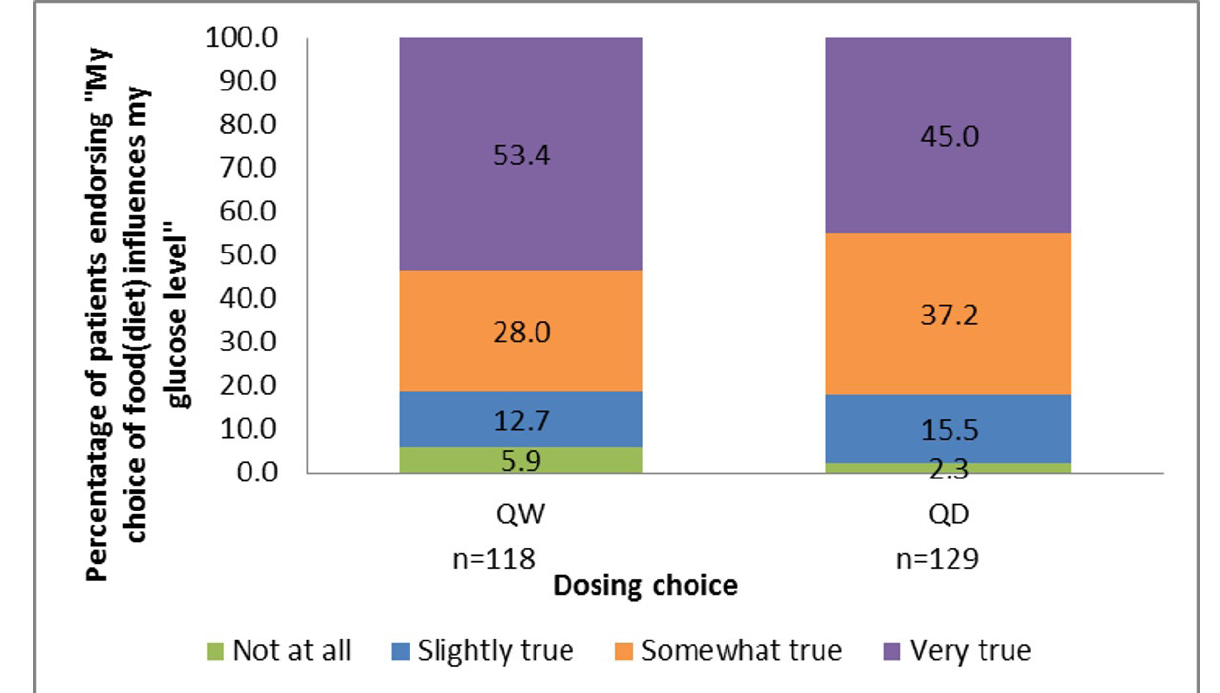
Figure 6. Dosing Preferences for Treatment Naive Groups of Patients with different Perceptions of Food (diet) Influencing their Glucose